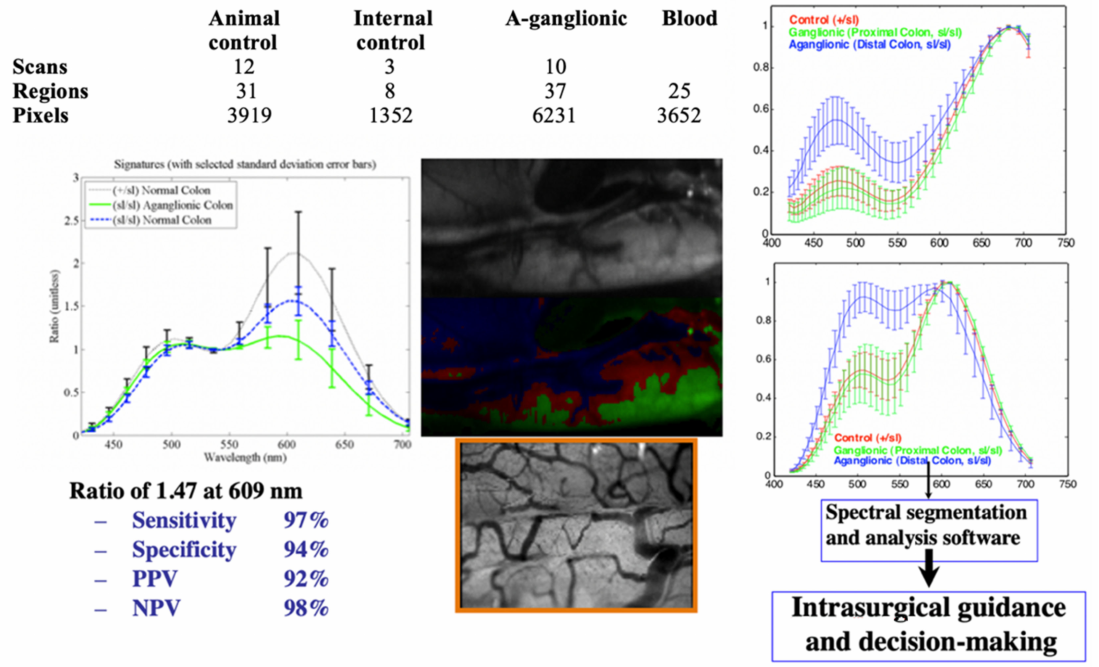
Figure 17. Delineating Hirschsprung’s Disease intraoperatively in an animal model by spectral imaging [128]. Spectral reflectance differences between normal and aganglionic (Hirschsprung-diseased) colon yielded (fast and with very high con- fidence) a separation between these regions. The (pseudocolor) red transition zone is where the surgical cut is recommended, in